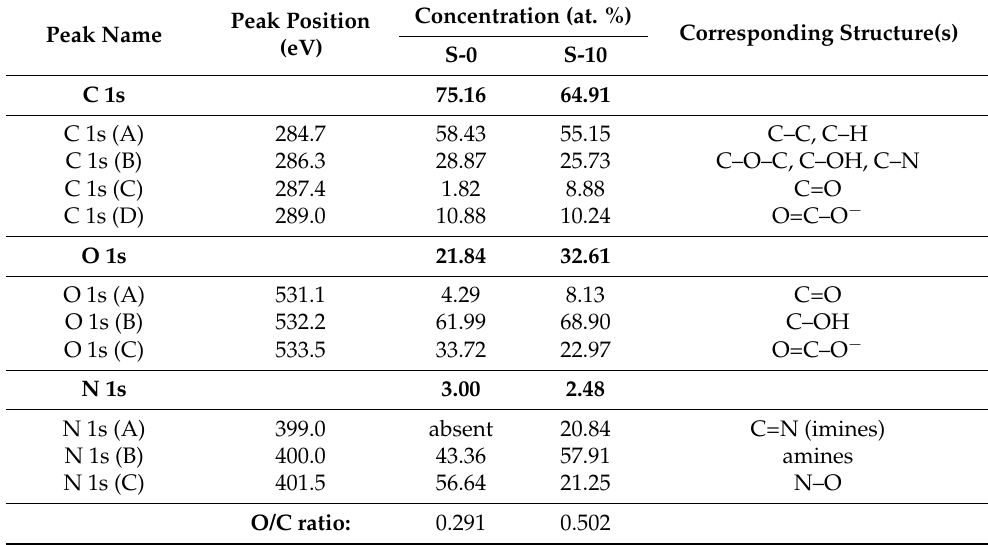
Table 3. The results of XPS analysis of the non-modified sample and the sample modified for 10 s.